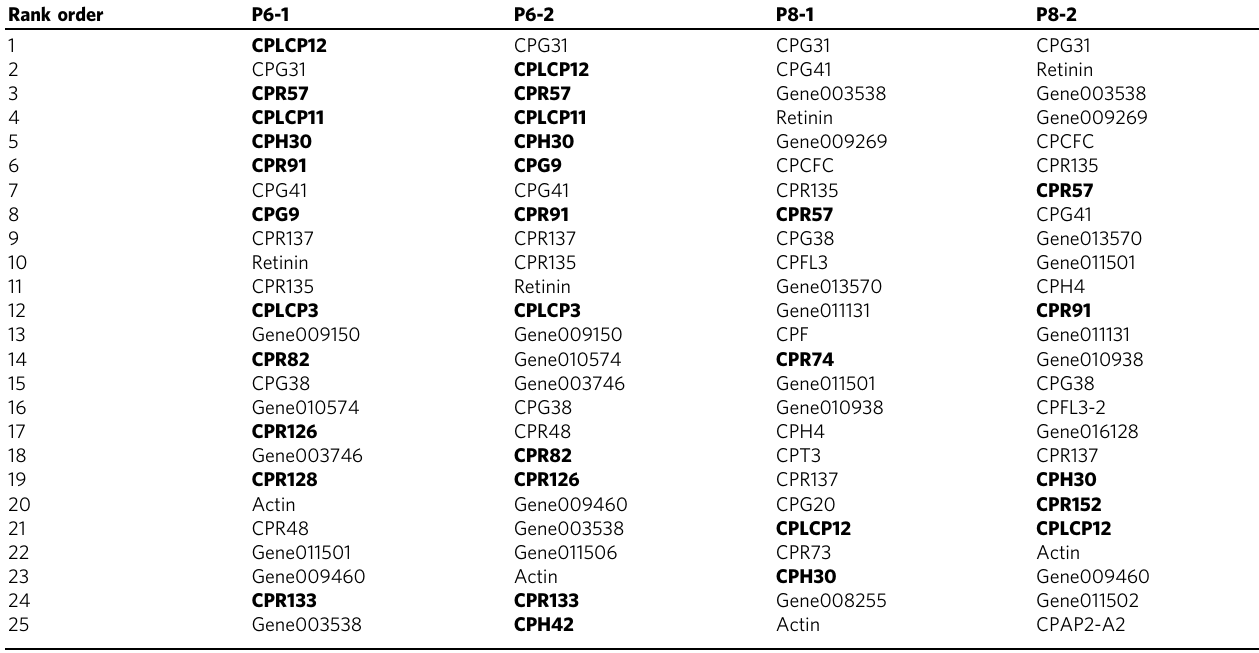
Table 1 Rank order of the most abundant proteins recovered based on iBAQ scores (data from Supplementary Data 1 – 4). Rank